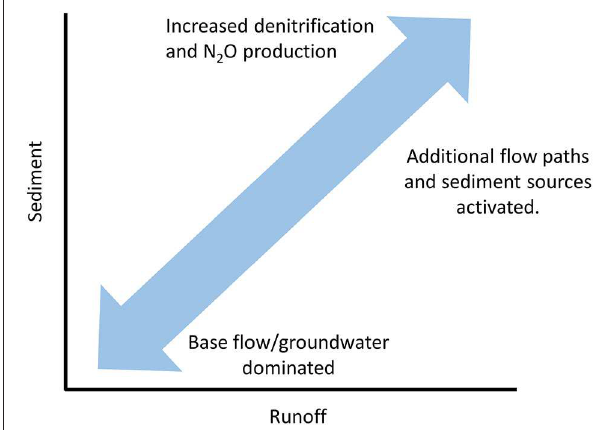
FIGURE 4 | A hypothetical relationship between sediment and runoff and rates of denitrification and N 2 O production associated with sediment load. Under elevated runoff, sediment concentrations increase due to the activation of addition flow paths and sources from the hillslope and watershed. The additional production of sediment will increase the abundance of anoxic microsites and conditions for denitrification and potentially N 2 O production. Note that this simplified model assumes no change in the size distribution of sediments which could influence rates of biogeochemical